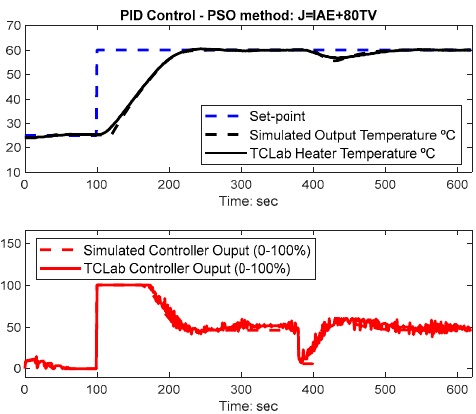
Figure 15. Simulated and TCLab responses using PSO, case III (J = IAE + 80 TV).